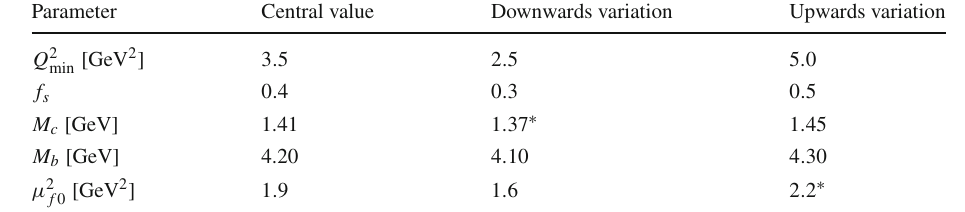
Table 2 Central values of model input parameters and